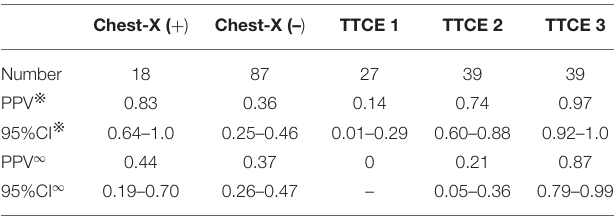
TABLE 3 | Number of patients and PPV for Chest-X results and TTCE grade. Chest-X ( +